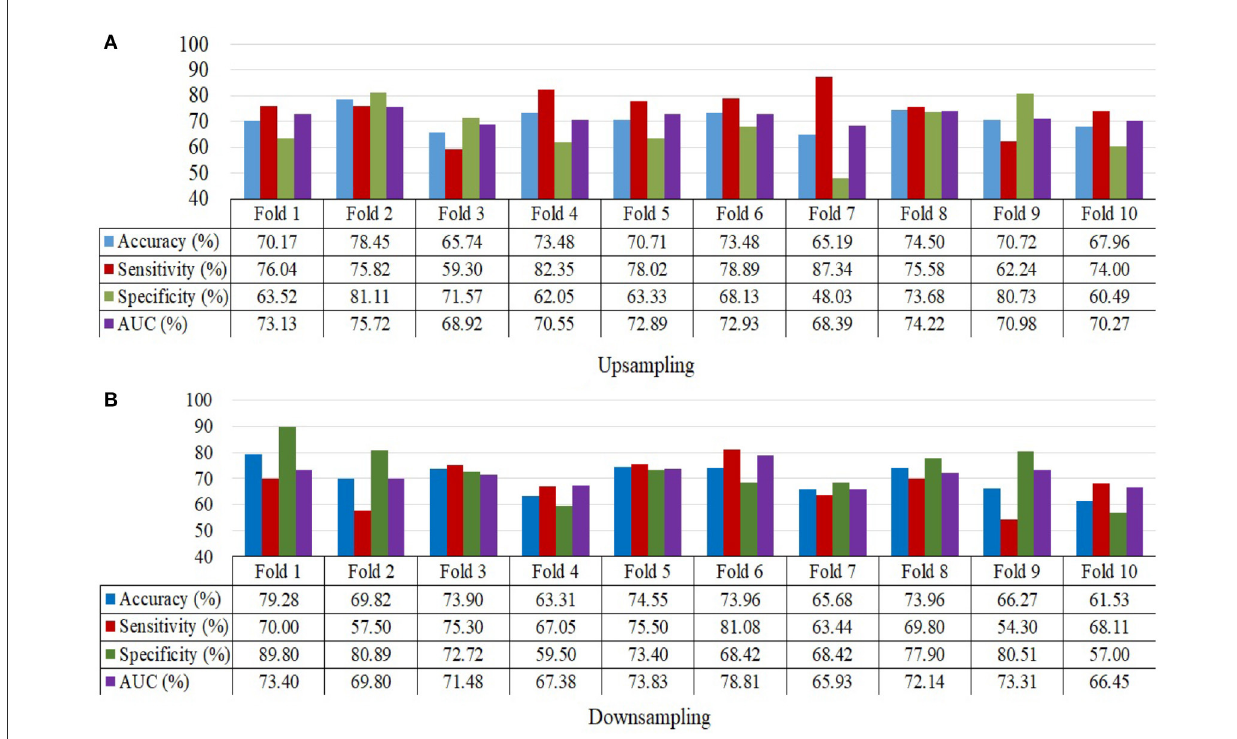
FIGURE5 10-Fold cross validation for MDD and HC samples depicting accuracy, sensitivity, specificity and the area under the curve. (A) Upsampling and (B)